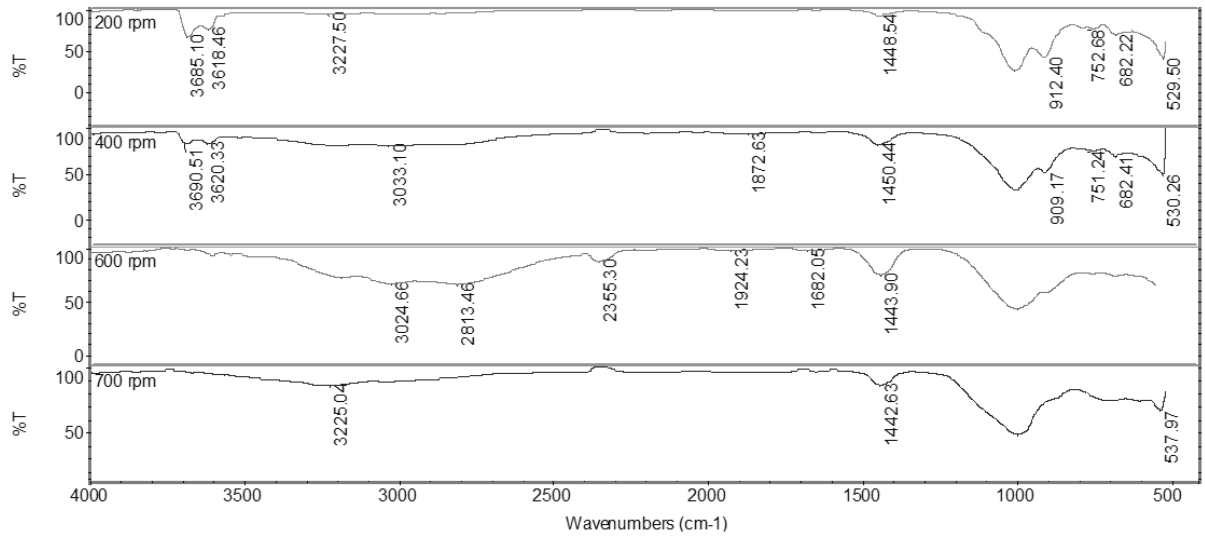
Figure 2. FTIR spectra of Kaolin-(NH 4 ) 2 HPO 4 samples milled at different milling speed for Figure 2: FTIR spectra of kaolin–(NH 4 ) 2 HPO 4 samples milled at different milling speed for 120 min 120 min. and disappear for samples prepared at 700 rpm, according to the spectra of kaolin–(NH 4 ) 2 HPO 4 sample